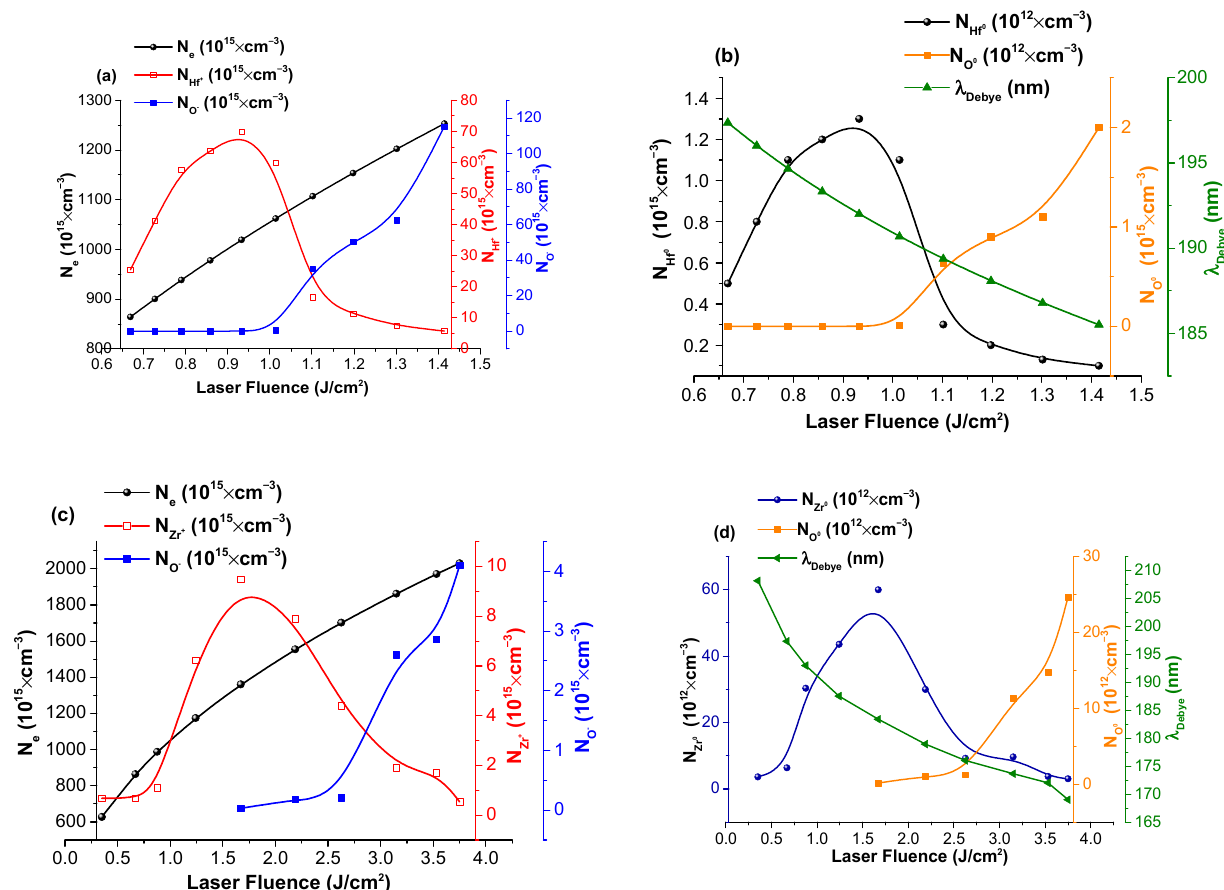
Figure 7. Particle densities and Debye length evolution with laser fluence for HfO 2 ( a , b ) and ZrO 2 ( c , d ).